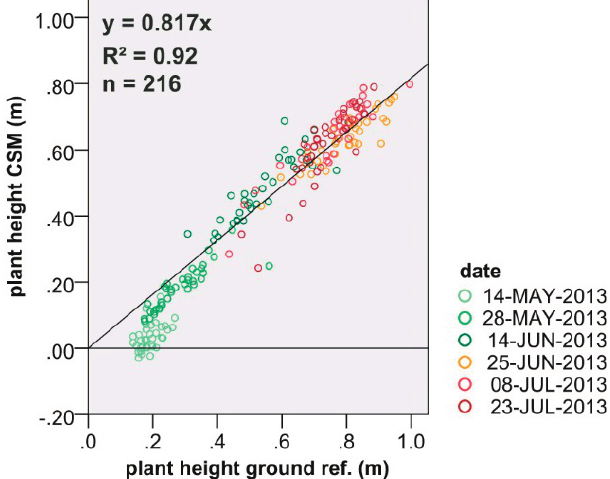
Figure 3. Scatter plot for PH determination; p < 0.0001 for all R 2